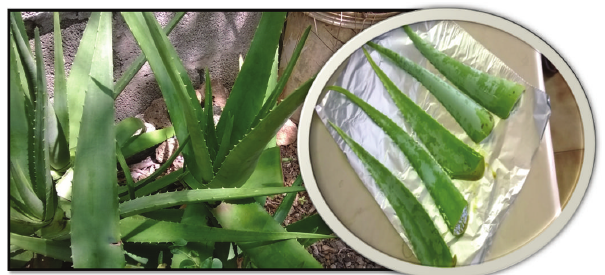
Figure 1: Freshly cut Aloe vera